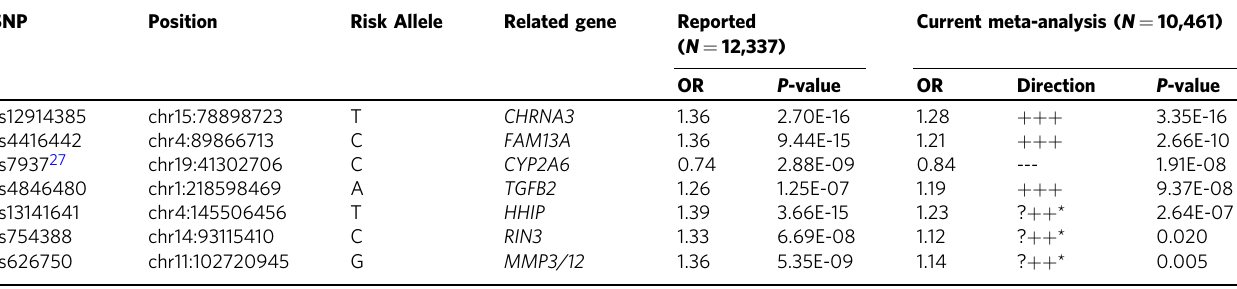
Table 2 Recovery of GWAS-identi fi ed variants, following application of our protocol to each of 3 GWAS and their meta-analysis, compared to published risk loci for COPD with combined data from COPDGene, ECLIPSE, NETT/NAS, and GenKOLS (Norway) 24